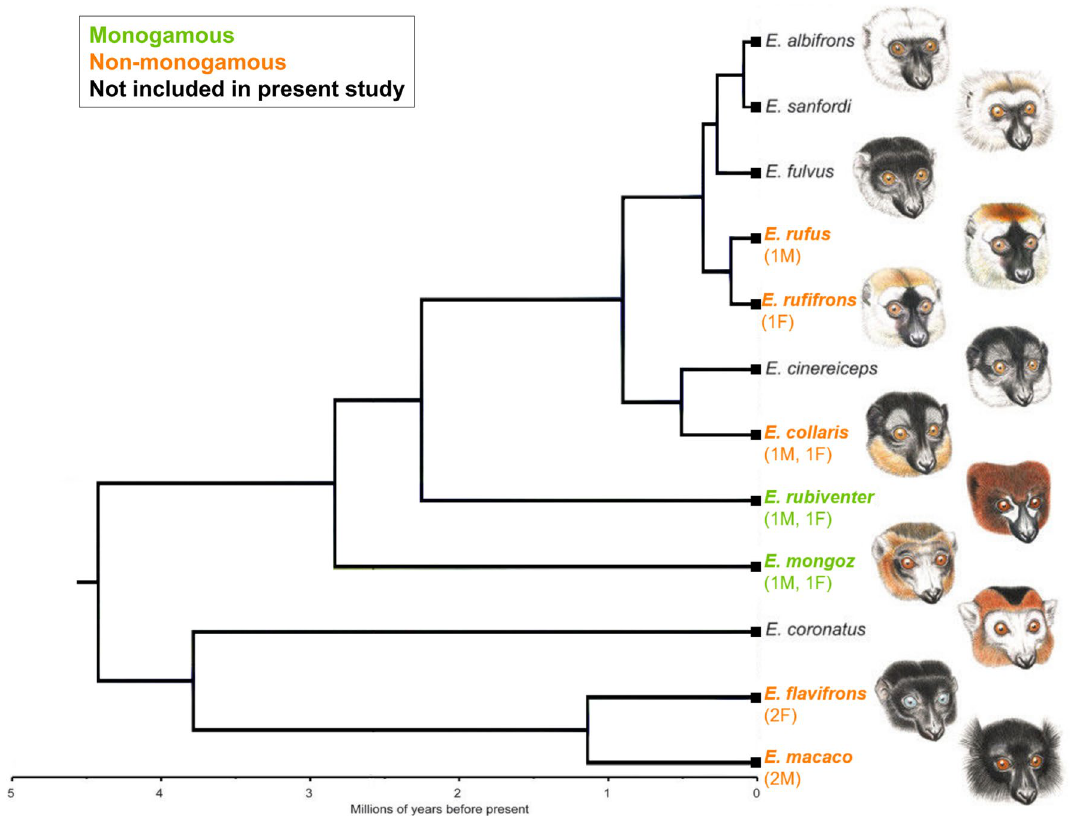
Figure 1. The mating system classification of seven Eulemur species at the Duke Lemur Center and their phylogenetic relationships, adapted from 39,51 . The number and sex of specimens from each focal species is denoted in parentheses. The source figure 51 is published under a creative commons attribution